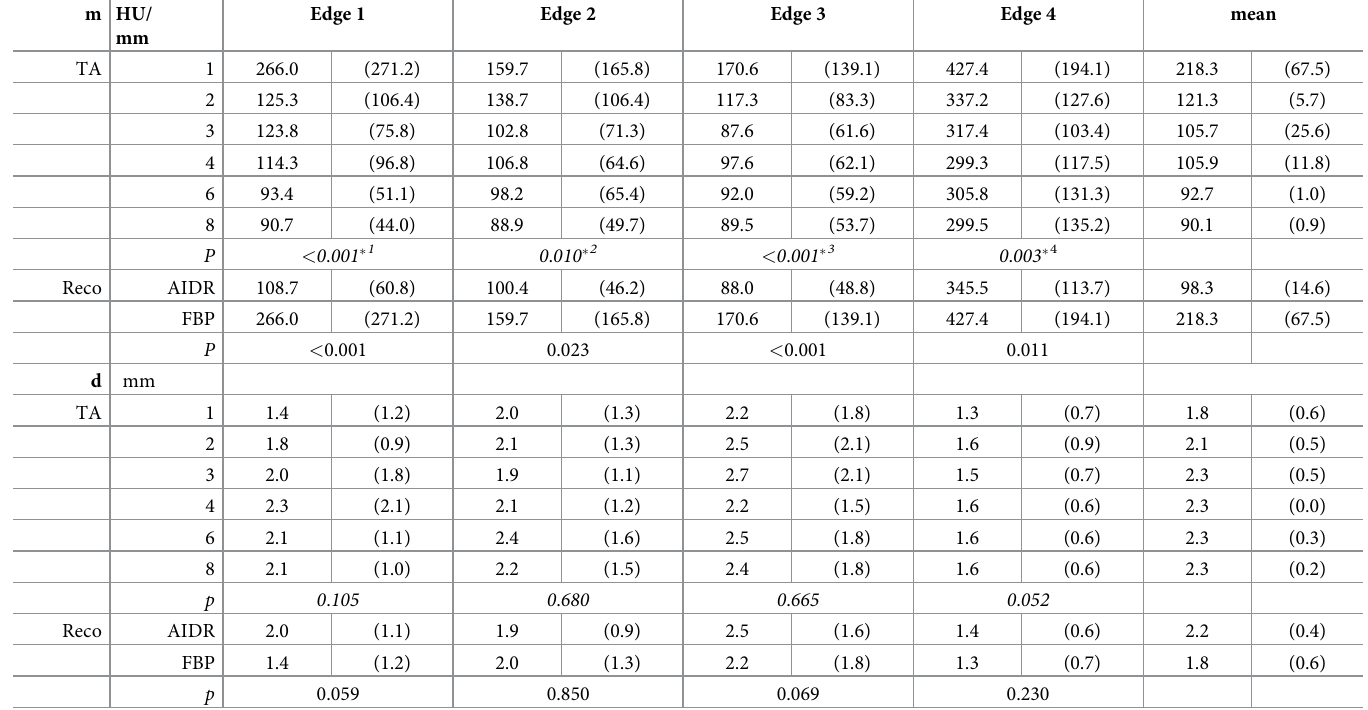
Table 2. Comparison of m and d between different reconstructions and levels of temporal averaging.